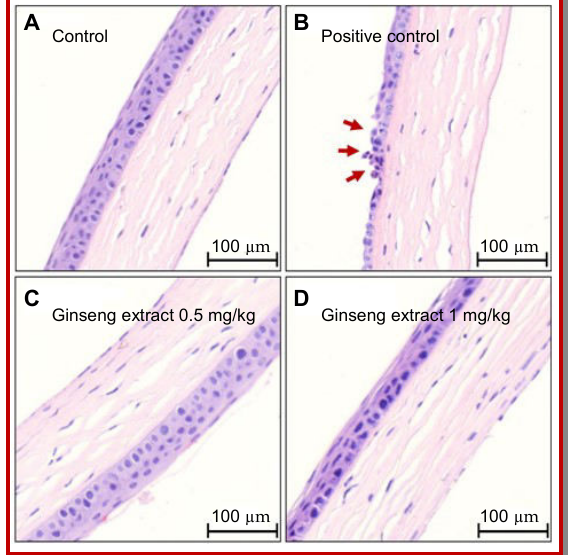
Figure 3: Effect of ginseng extract on corneal epithelial cells of benzalkonium chloride-induced mice. Red arrows indi- cates irregular and vacuolated corneal epithelial cells